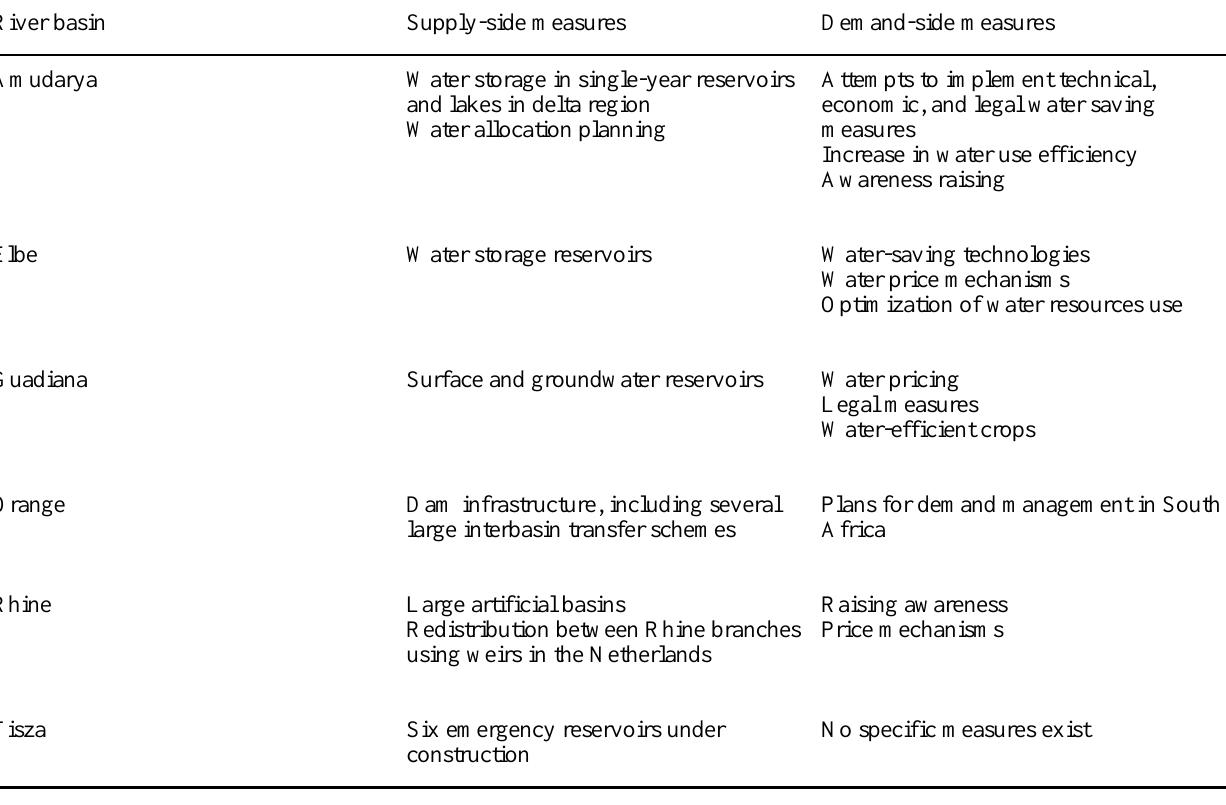
Table 6B. Drought control